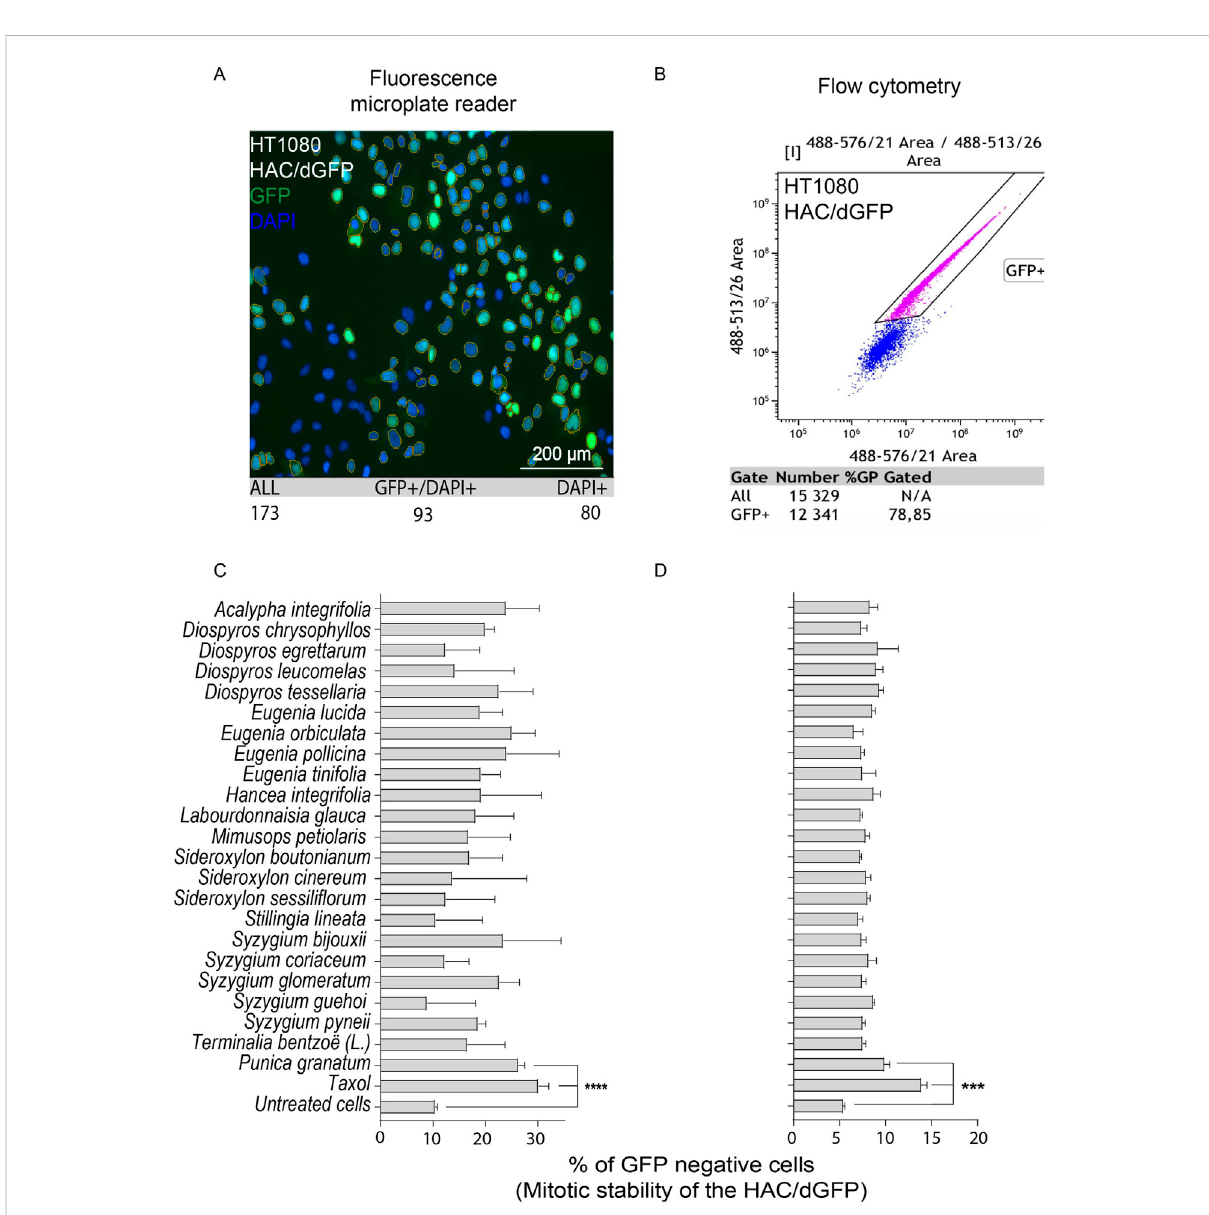
Mitotic stability of the HAC/dGFP in human cancer HT1080 cells treated with the natural extracts. Mitotic stability was measured by a fl uorescent microplate reader (A,C) and fl ow cytometry (B,D) . Among 24 extracts analyzed, the strongest effect on the HAC/dGFP stability was demonstrated by the cells treated with the Punica granatum leaves extract (PLE). Asterisks indicate statistical signi fi cance above negative control ( T -test, p <